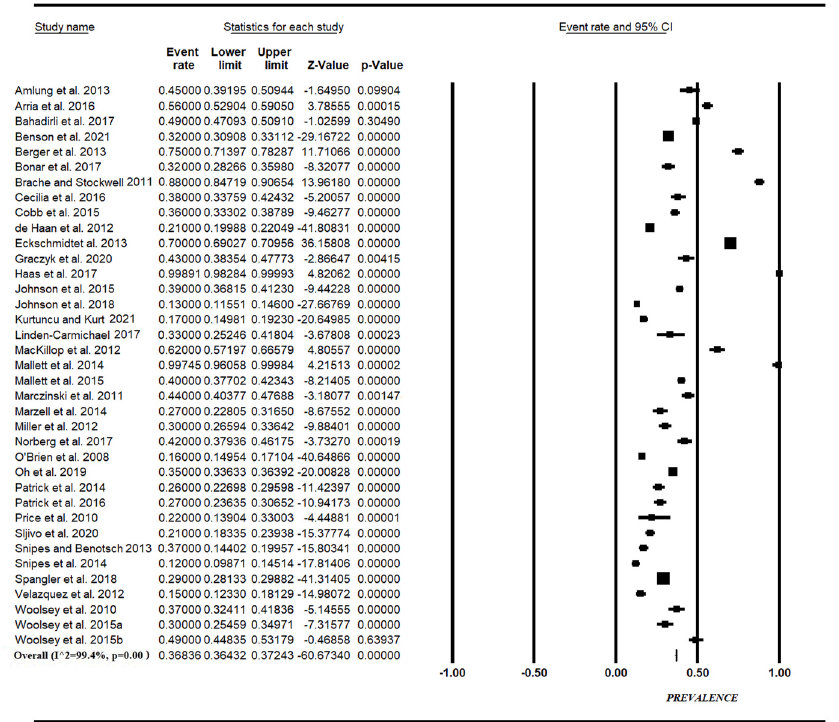
Figure 2. Forest plot for the prevalence of AmED consumption in students [27–43,45–65]. A visual inspection of funnel plot suggested no publication biases in the present study ( p = 0.001) (Figure S1).